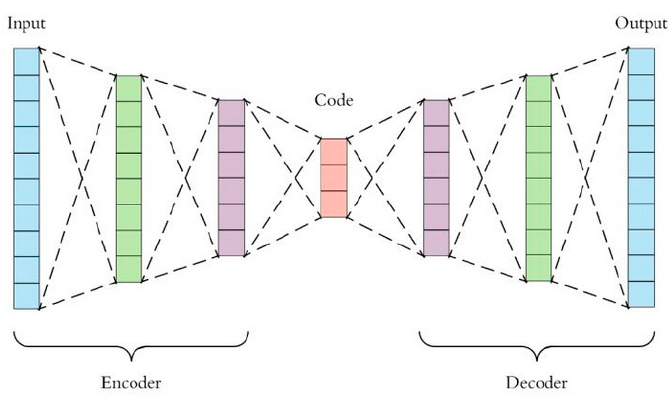
Figure 4. Structure of an autoencoder adopted in the VAE model of this study.